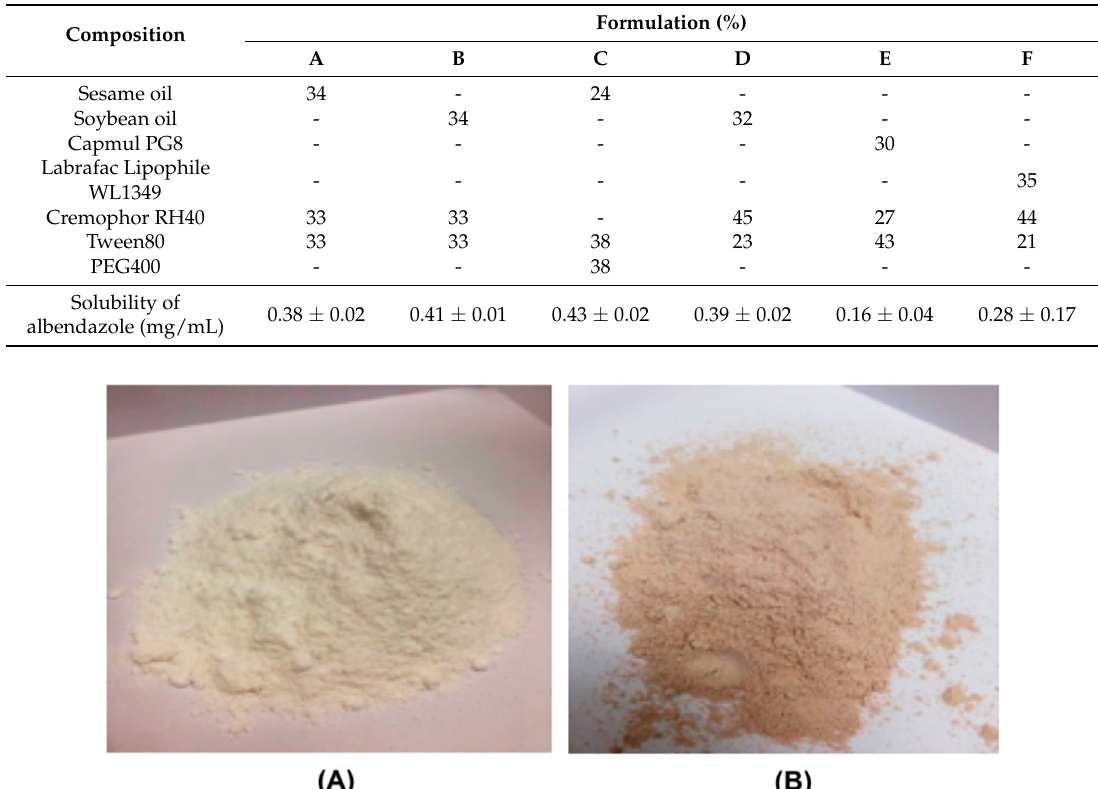
Table 3. Solubility of albendazole in selected self ‐ microemulsifying formulations.